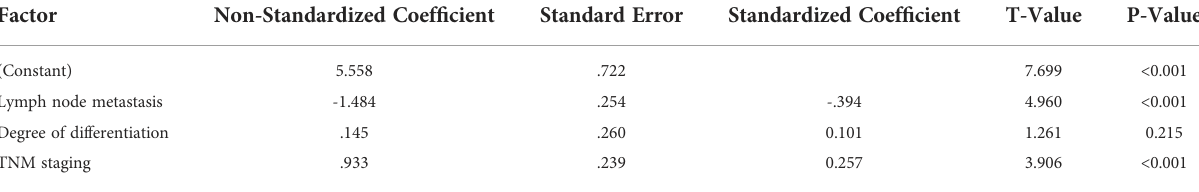
TABLE 2 Multi-factor analysis of the IL-6 level in patients with colorectal cancer.